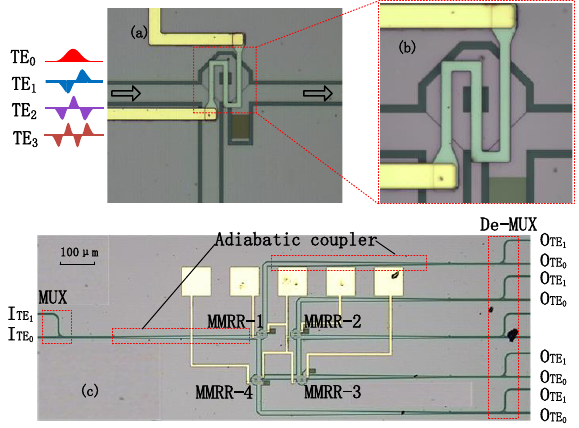
Figure 5: (a) Microscopeimage of the fabricated MMRR. (b) Zoom-in view. (c) Image of the fabricated cascaded